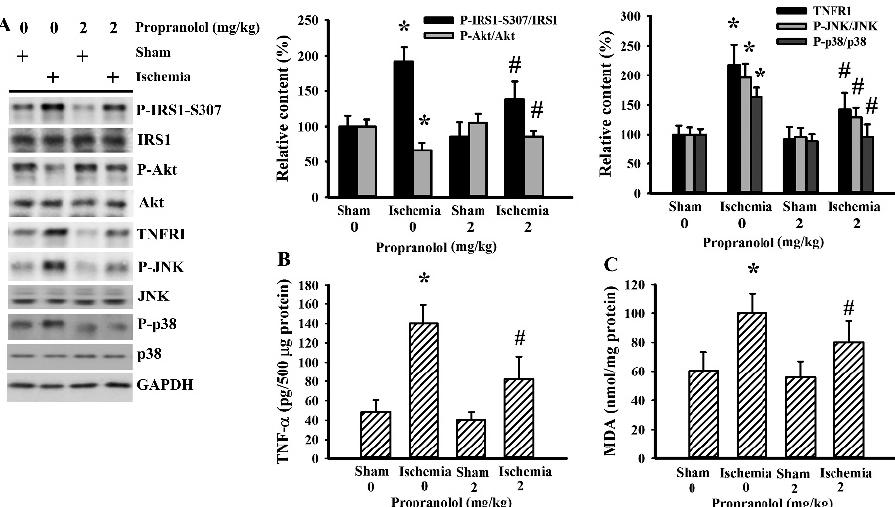
Figure 7. Propranolol alleviated postischemic gastrocnemius inflammation. Rats receiving a normal saline vehicle or a propranolol (2 mg/kg) intraperitoneal injection were subjected to sham and permanent cerebral ischemia for 24 h. ( A ) Proteins were extracted from the gastrocnemius muscles and subjected to Western blot with the indicated antibodies. ( B ) Proteins were extracted from the gastrocnemius muscles and subjected to ELISA for the measurement of TNF- α . ( C ) The contents of MDA in the gastrocnemius muscles were measured. * p < 0.05 vs. the sham/saline group and # p < 0.05 vs. the ischemia/saline group, n = 6.